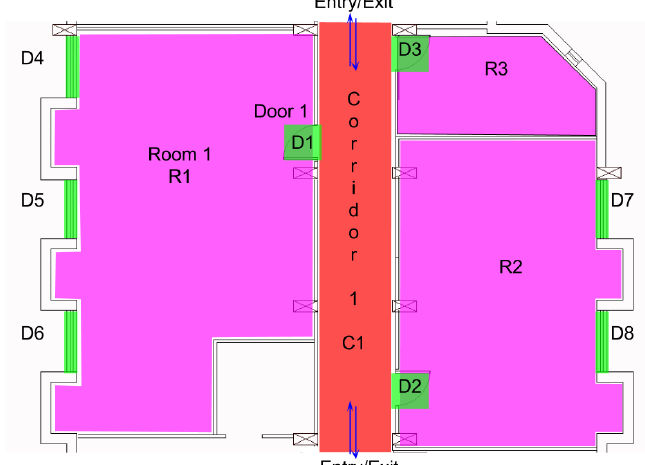
Figure 4. Depiction of rooms (pink), corridors (red) and openings (green) [33].